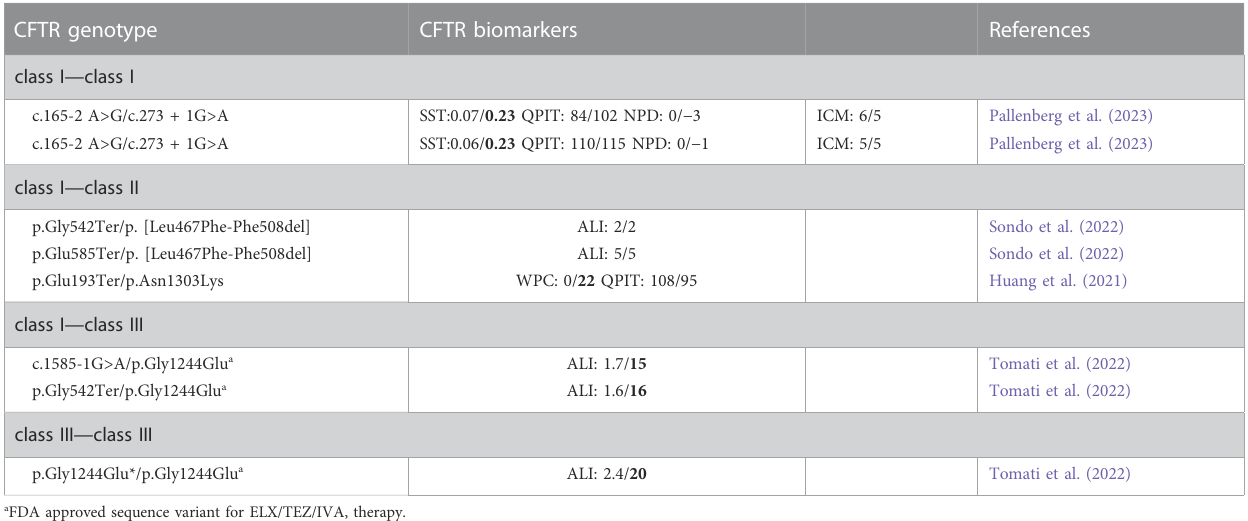
TABLE 2 Rare non-p.Phe508del CFTR genotypes assessed for ELX/TEZ/IVA — mediated CFTR modulation in pwCF by CFTR biomarkers. Sequence variants are differentiatedby CFTR mutationclass:classI,minimalfunction;classII,defectiveinproteinprocessingandtraf fi cking;classIII:defectivegating;classIV,changeof ion channel conductance; class V, reduced amount of wild type